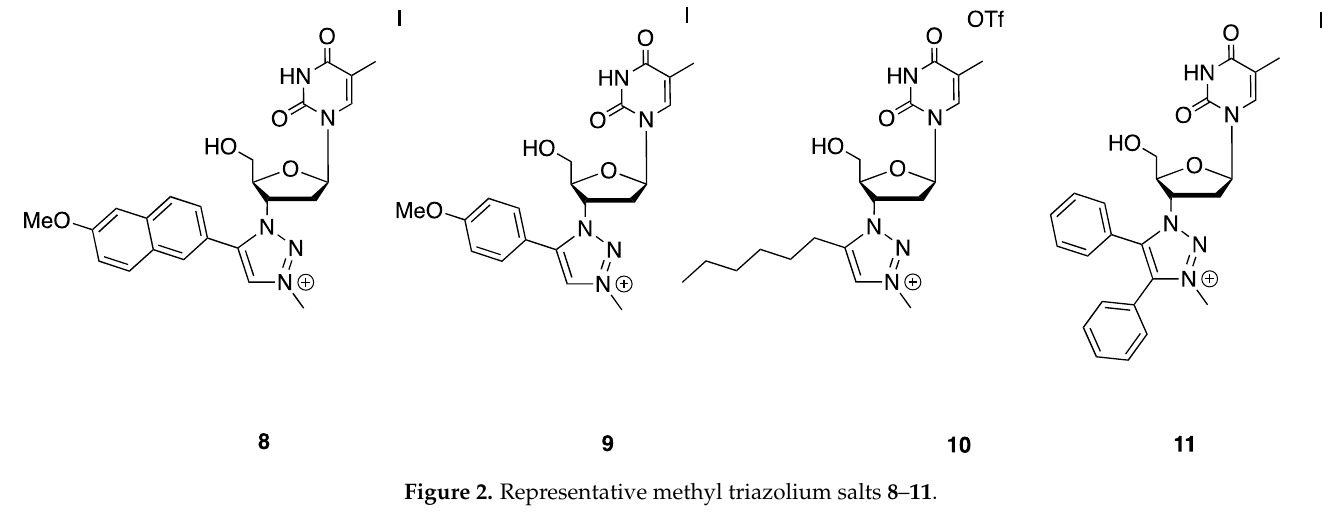
Figure 2. Representative methyl triazolium salts 8 – 11 .